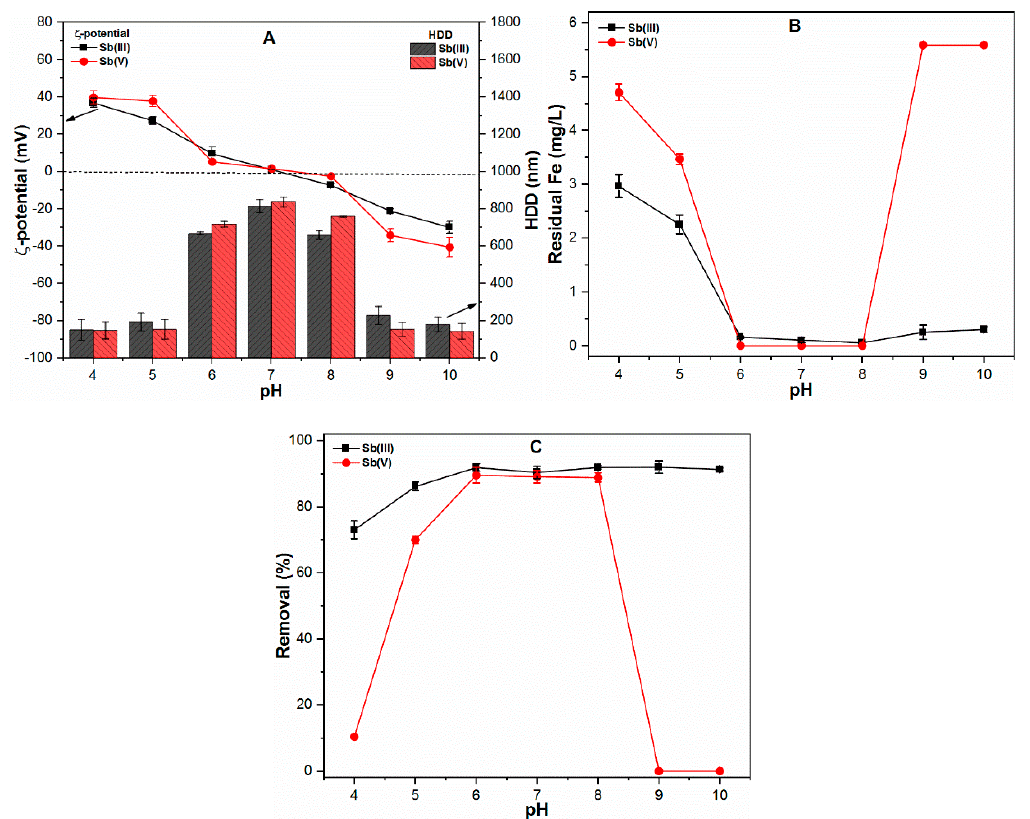
Figure 1. At various pH ranges (4–10), ferric chloride (FC) dose (0.1 mM), temperature (25 ± 1 °C) and Sb(III, V) concentration (1 mg / L) showing ( A ) ζ -potential (mV) and hydrodynamic diameter (HDD) (nm) of precipitates; ( B ) Residual Fe (mg / L); and ( C ) Removal (%) of both Sb species.